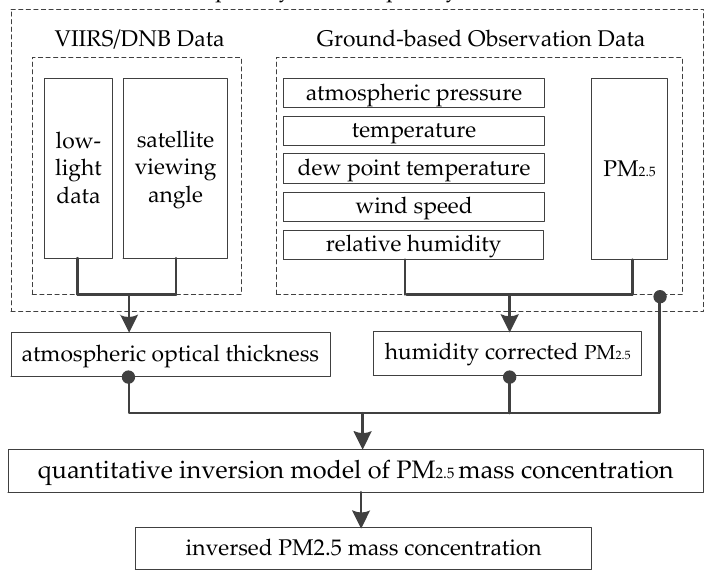
Figure 3. Flow chart of the PM 2.5 mass concentration inversion model.